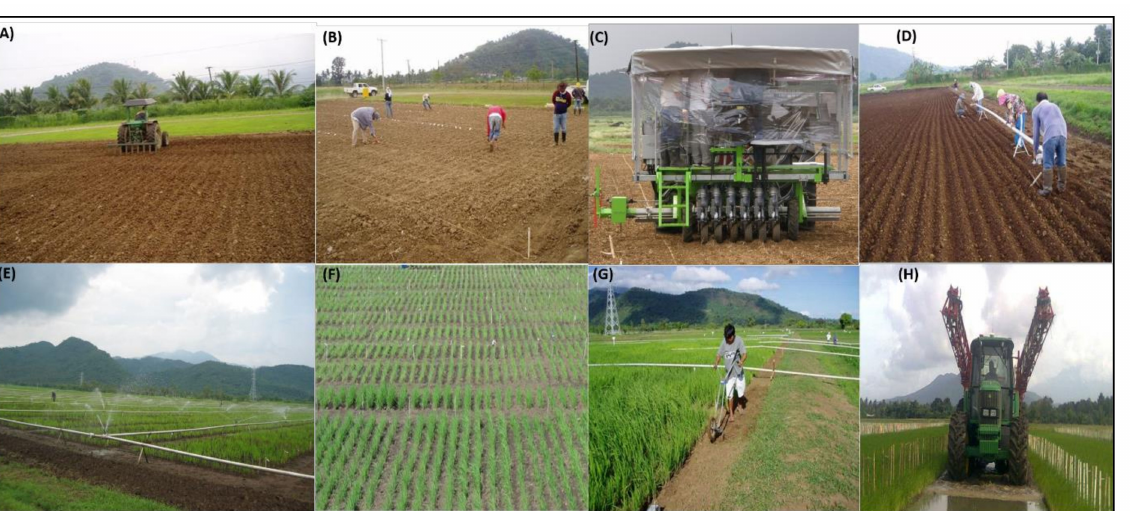
Figure 4. Agricultural practices followed in direct seeded rice cultivation systems: ( A ) land preparation, ( B ) manual seed sowing, ( C ) seed showing using mechanized seed drill, ( D ) installation of sprinkler irrigation system, ( E ) irrigation through sprinkler system at seedling stage, ( F ) field view of DSR field at seedling stage, ( G ) manual weed control using wheel hoe, ( H ) mechanized weed control using boom tractor